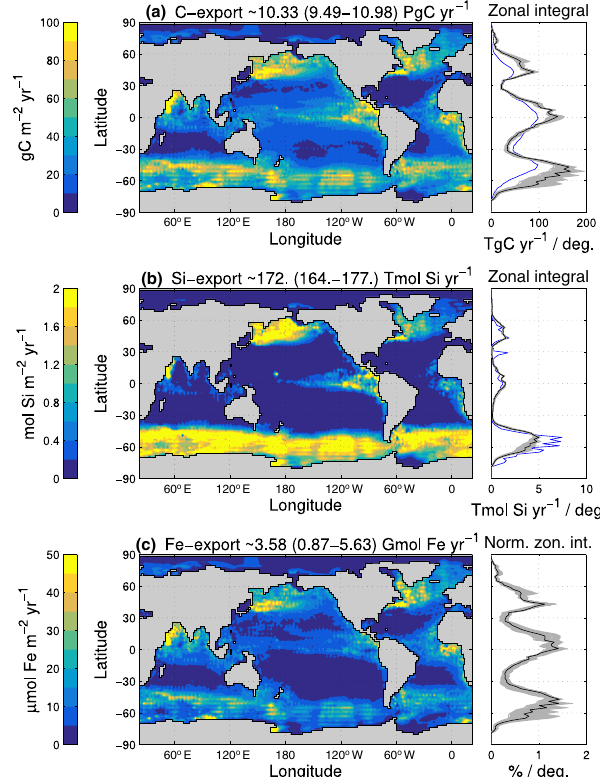
Figure 5. Local export production for each nutrient (maps on the left) and its zonal integral (curves on the right). Maps are shown for our typical state estimate, while we plot the zonal integral of each family member (scaled for dFe) in grey and the typical state esti- mate in black. (a) Phosphorus export, expressed in carbon units us- ing C : P = 106 : 1. The blue zonal integral is the export production estimate of Primeau et al. (2013). (b) Opal export, where the blue zonal integral is the estimate of Holzer et al. (2014). (c) Iron ex- port, with its zonal integrals expressed as a percentage of the global iron export. The globally integrated exports for the typical estimate are indicated in the plot titles together with their ranges across the family of estimates in